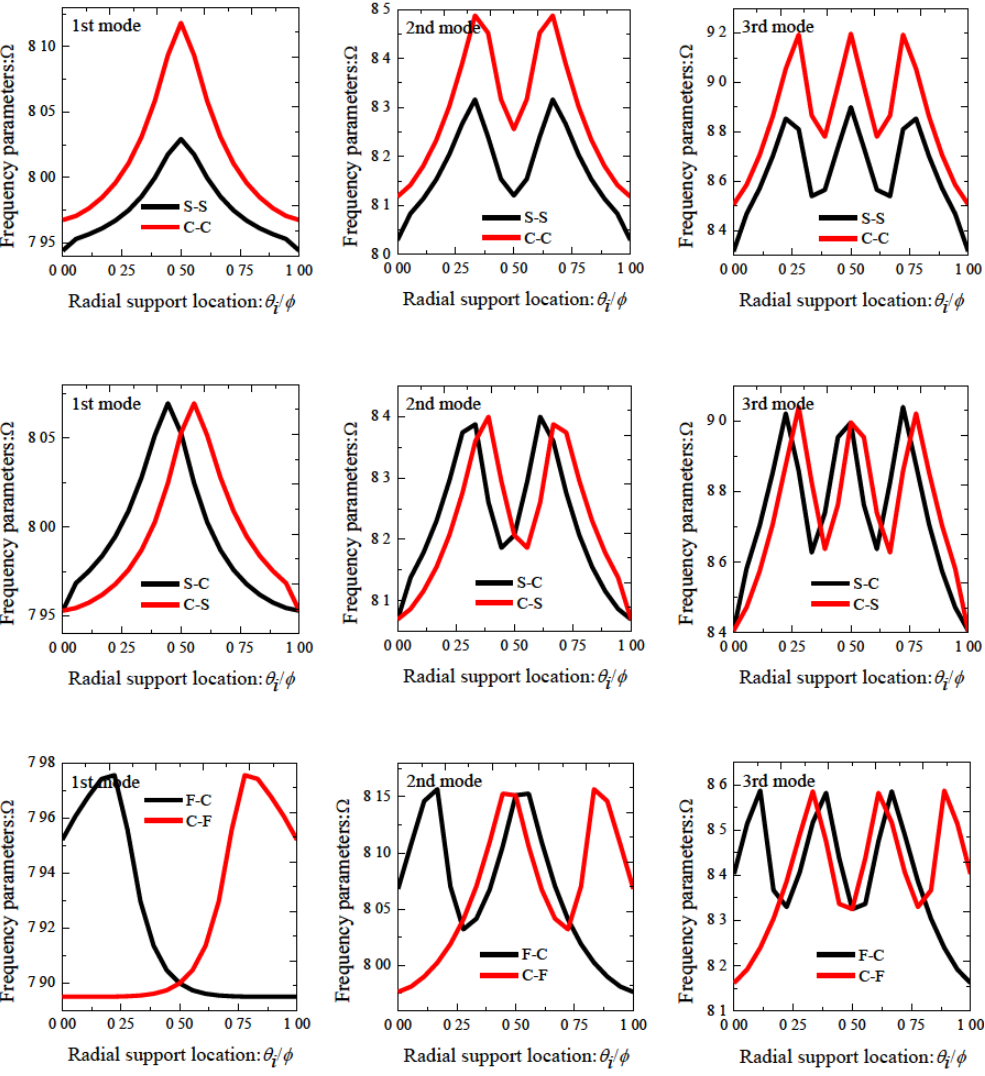
Figure 13: Variation of the frequency parameters Ω versus the radial support locations for a [0 ∘ /90 ∘ ] laminated annular sector plate with a θ direction internal radial support ( E 1 / E 2 =15, a / b =0.5, h / b =0.1, ϕ = π